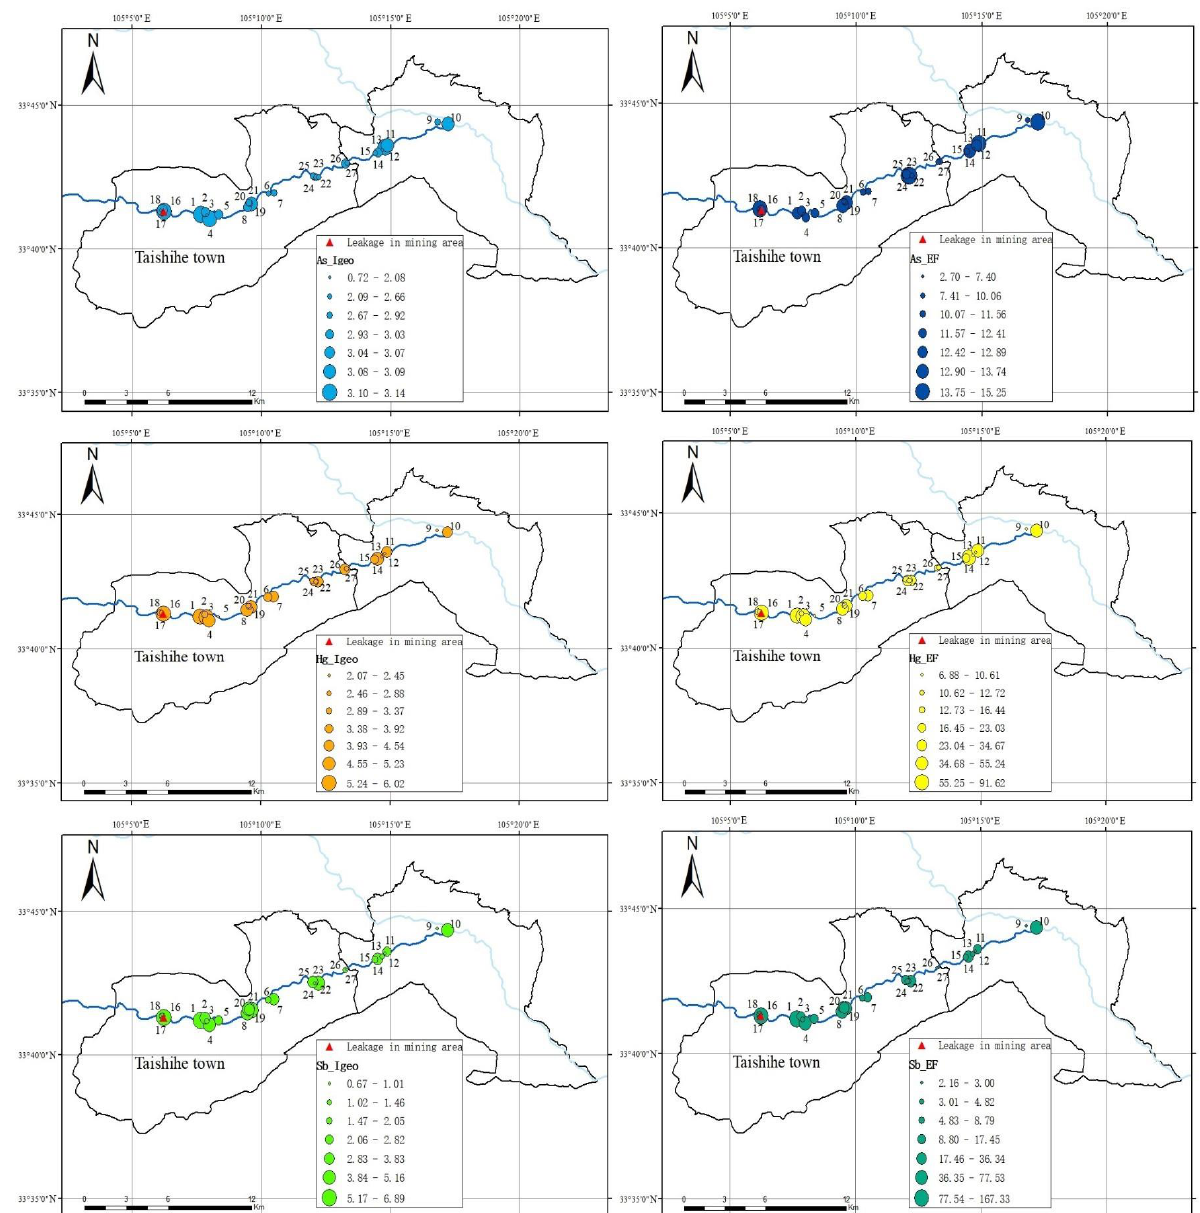
Figure 2. Spatial interpolation results of the content of heavily contaminated PTEs. The numbers next to the sampling locations indicate the numbers of the sampling points.